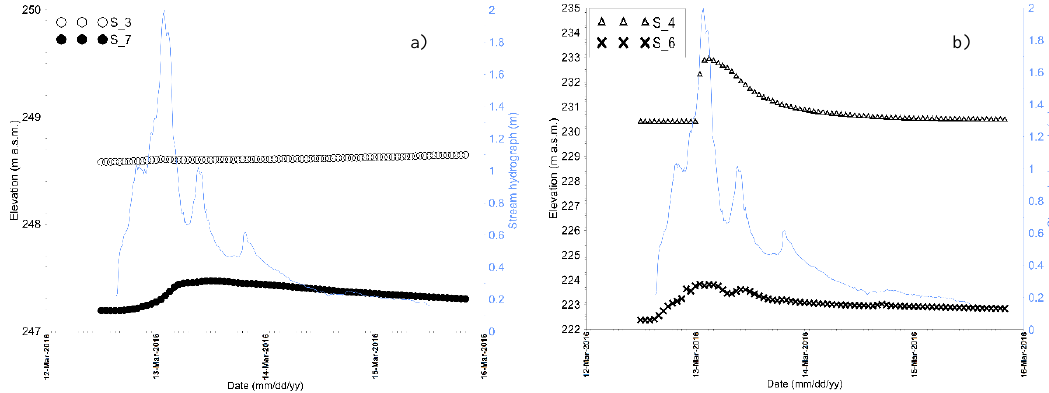
Figure 13. Stream hydrograph during the flood event of 13 March 2016 compared with groundwater level time series recorded in the piezometers S3 and S7 ( a ) and in S4 and S6 ( b